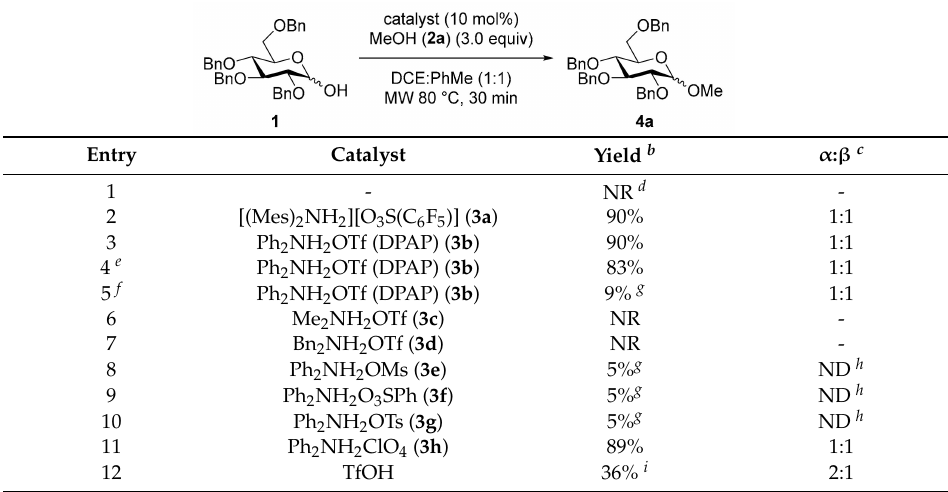
Table 1. Initial catalyst screen for the glycosylation of 1 a